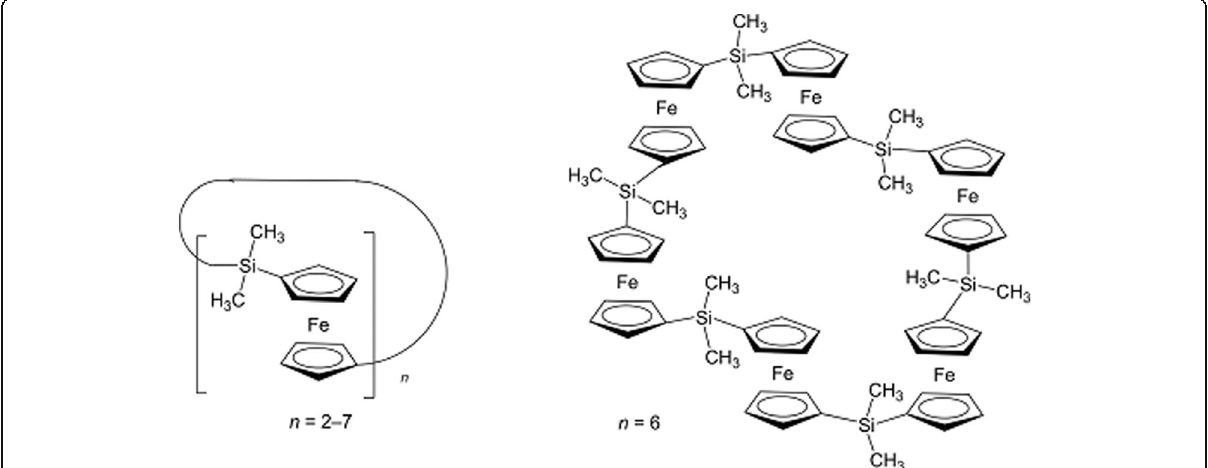
Fig. 2 Cyclic hexa(ferrocenyldimethylsilane). Electrostatics effect are only observed between a ferrocene group and its two neighbors, but not with further neighbors. As a consequence, two 3-electron waves are seen by cyclic voltammetry